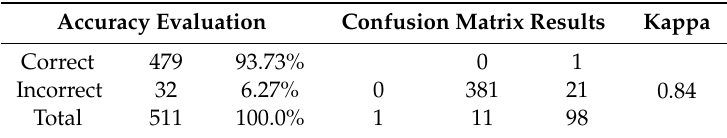
Table 3. Results for the training set.